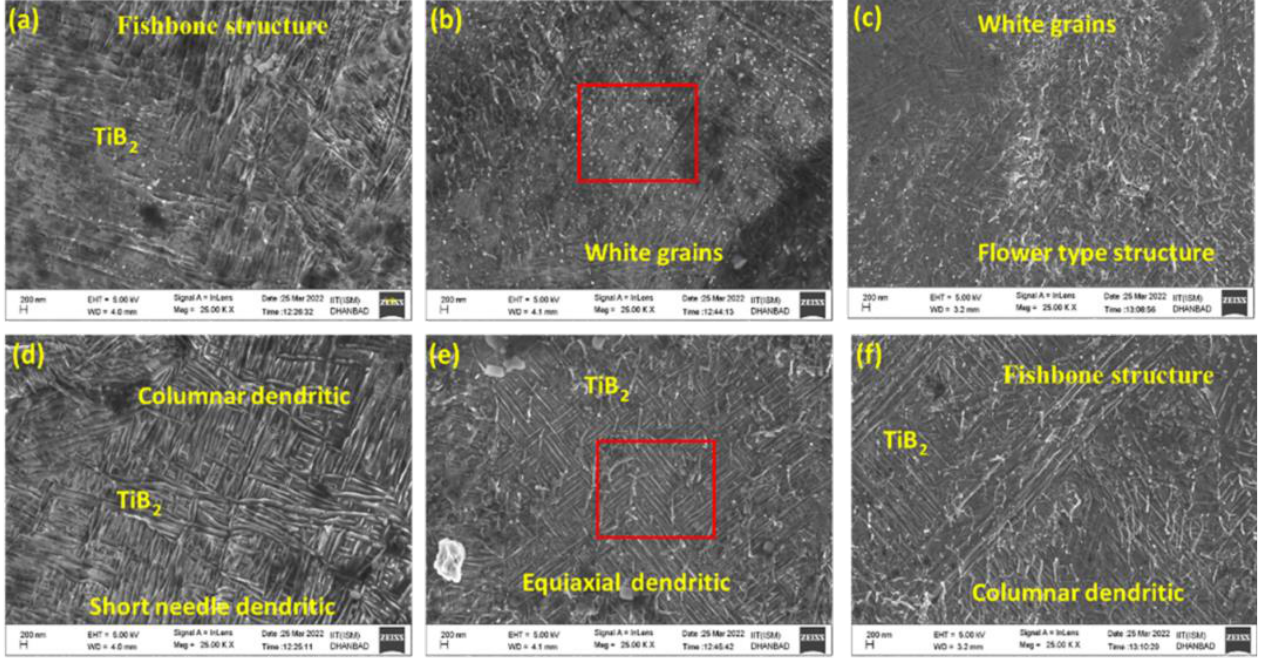
Figure 12. FESEM images indicating different microstructures on the prepared cladded samples showing ( a – c ) upper portion ( d – f ) middle portion [172].